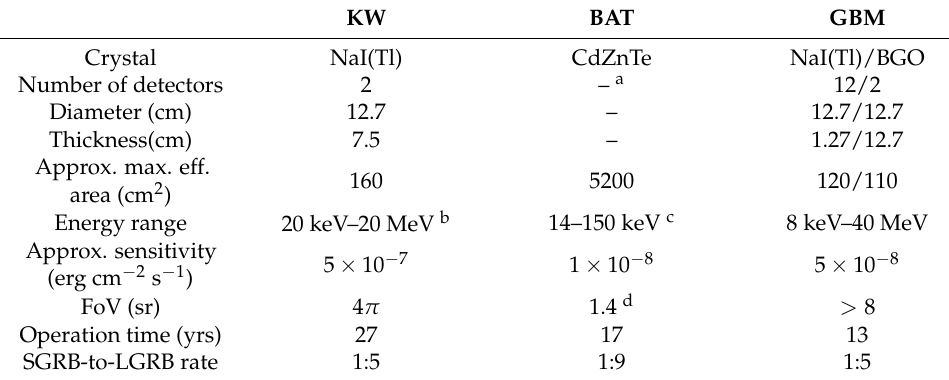
Table 1. Comparison of Konus-Wind, Swift-BAT, and Fermi-GBM properties. KW